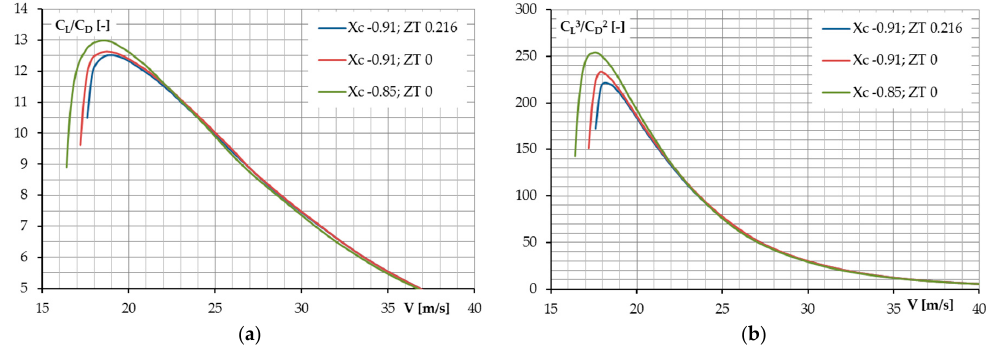
Figure 19. Variation in the airplane’s aerodynamic characteristics with the CG position: ( a ) C L / C D ratio; and ( b ) power coefficient C L3 / C D2 with respect to the airspeed.